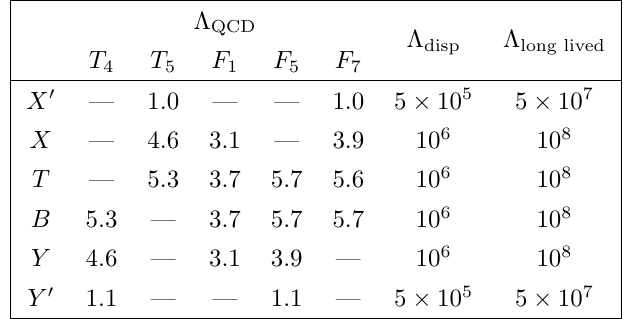
Table 6 . Value of 1 =y (in TeV) at which the total width reaches the scales (cid:3) QCD = 0 : 2 GeV, (cid:3) disp = 10 (cid:0) 12 GeV and (cid:3) long lived = 10 (cid:0) 16 GeV. For (cid:3) disp and (cid:3) long lived only an estimate of the order of magnitude is provided, obtained by extrapolation of the results above (cid:3) QCD